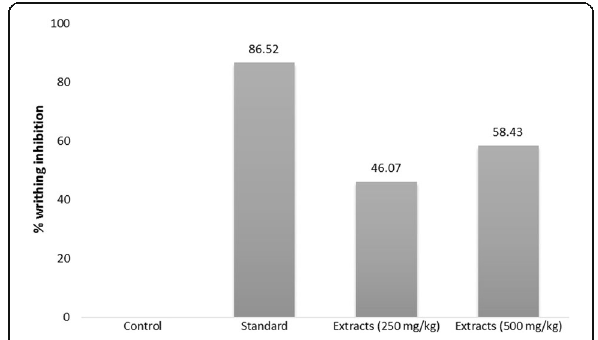
Fig. 5 Percentage writhing inhibition of acetic acid induced writhing in mice by the standard drug and Lepisanthes rubiginosa